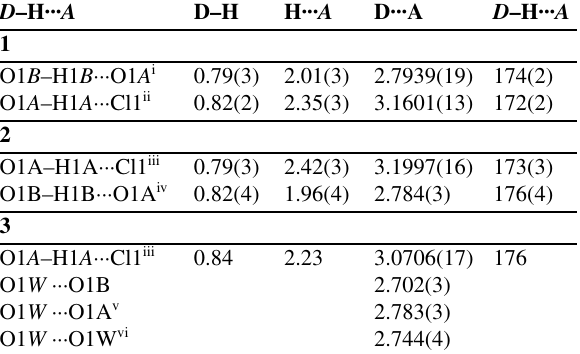
(3PM) molecules in polymorph 2 . 2 4